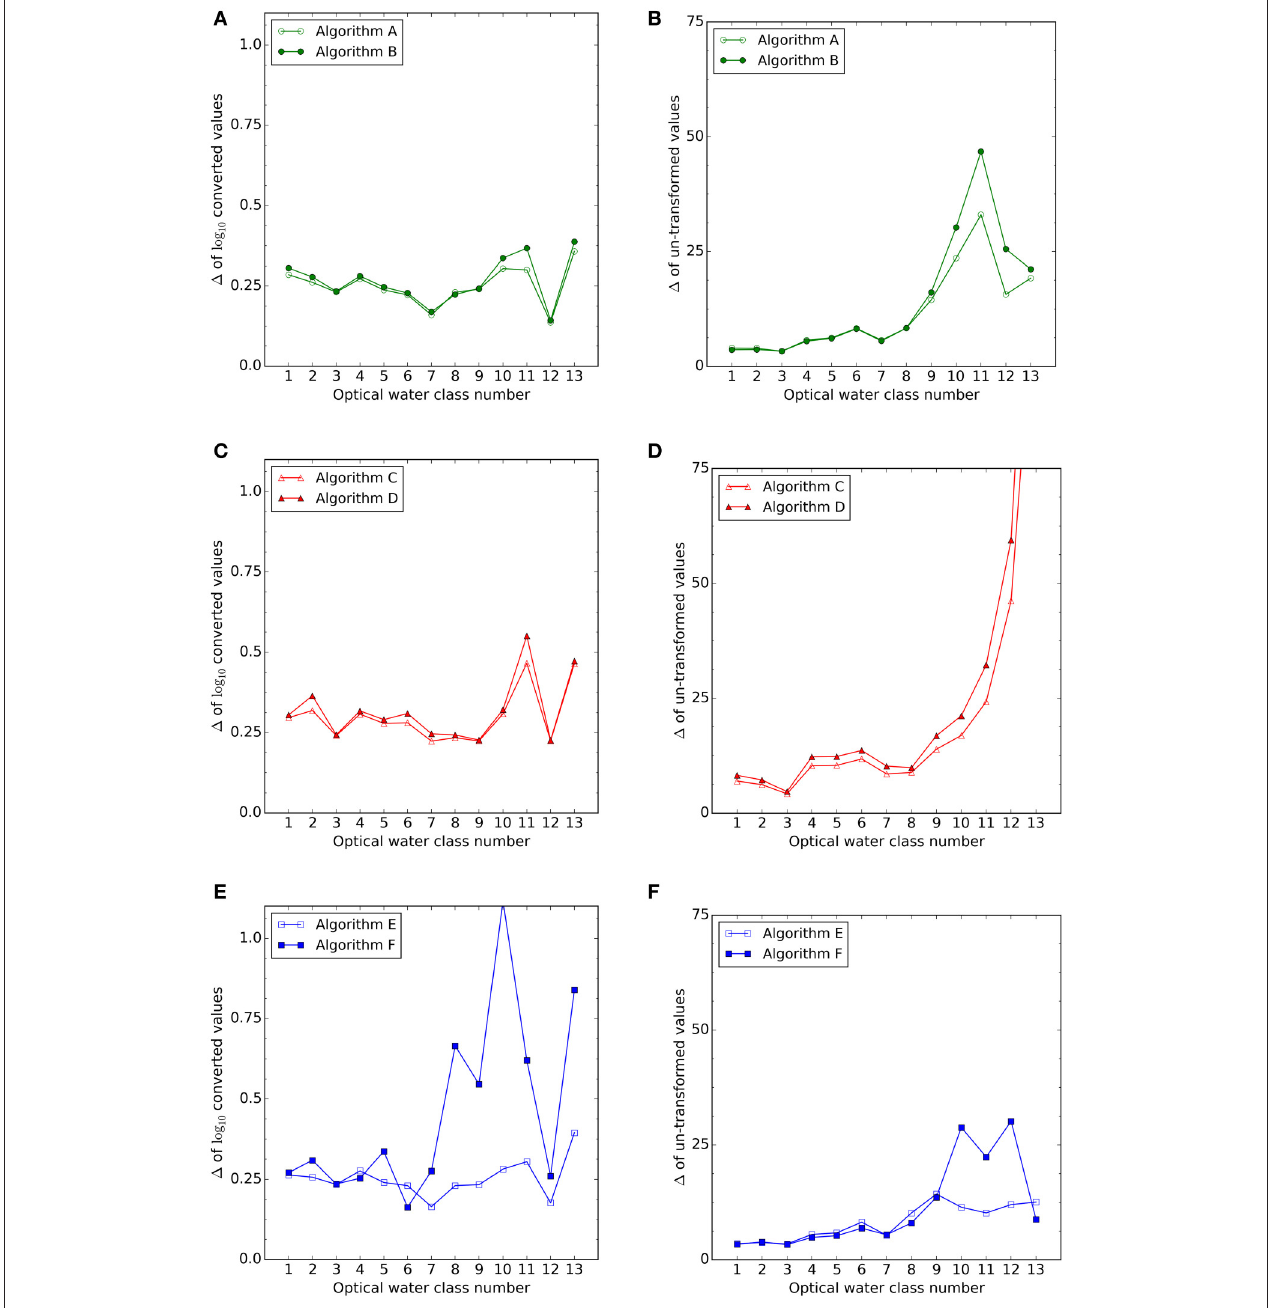
FIGURE 7 | Center pattern root mean square deviation ( 1 ) for log 10 (A,C,E) and non-transformed (B,D,F) data from the C phy match-up dataset per optical water class. Out of scale from the plot in (D) Algorithm C for water class 13 has 1 = 120 mgCm − 3 ; Algorithm D for water class 13 has 1 = 157 mgCm − 3 . (E) Algorithm F for water class 10 has 1 = 1.12 mgCm − 3